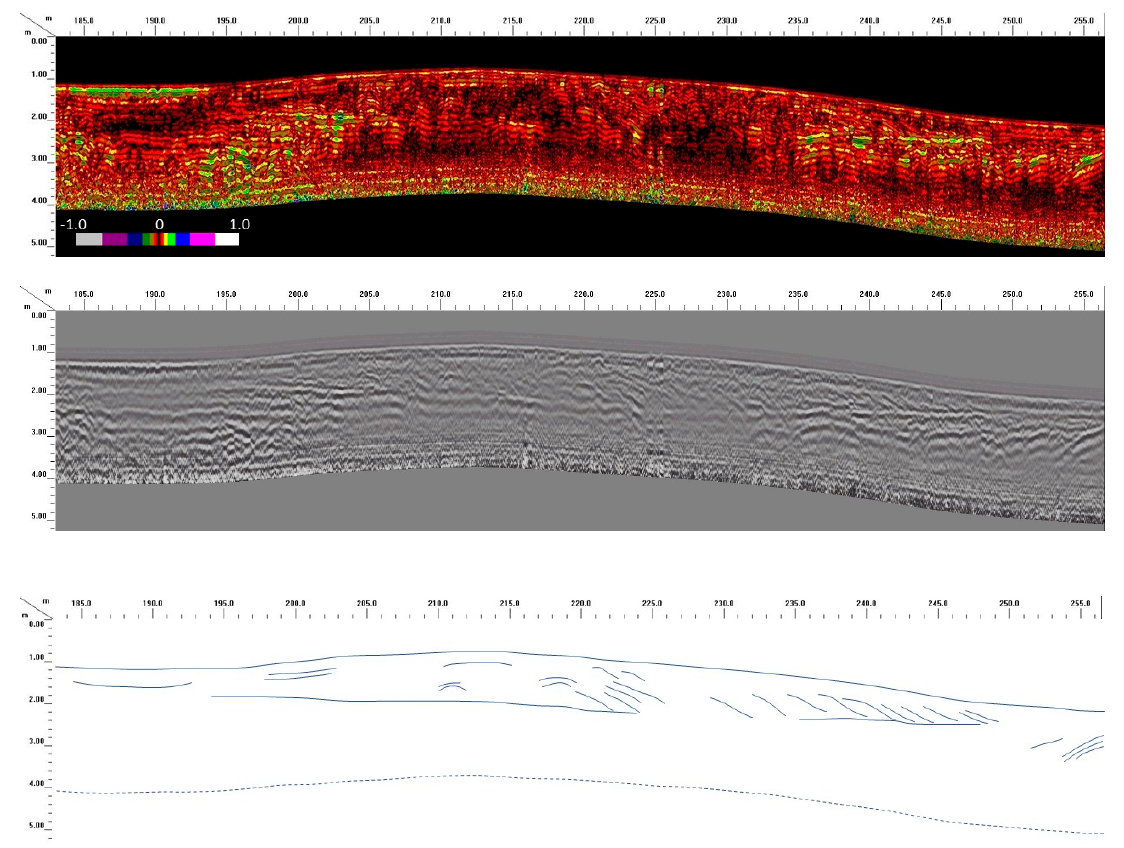
Figure 9. GPR profile and interpretation for the 1723 m shoreline. In the upper transect, data are presented with a color scale to highlight the normalized intensity of radar reflectors. The lower profile presents the same data in grayscale. In both profiles, landward is to the left and lakeward is to the right. Vertical exaggeration 3×.